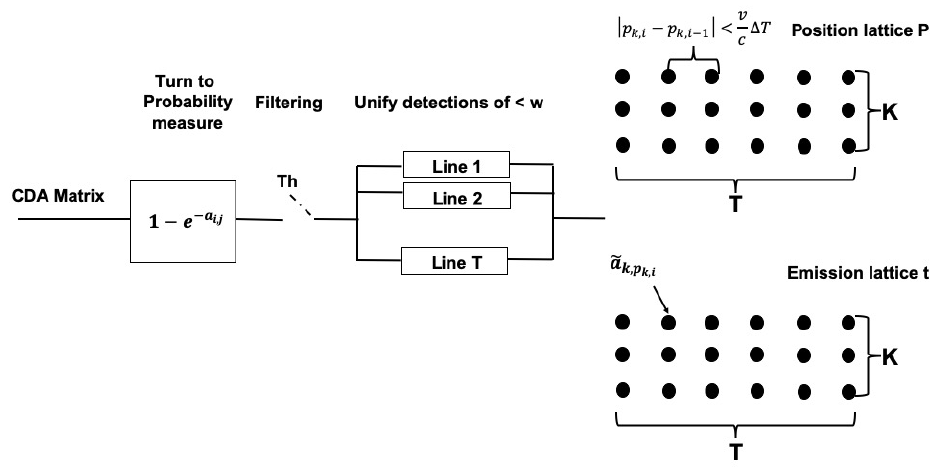
Figure 5. Block diagram for the processing of the CDA matrix before dynamic programming-based